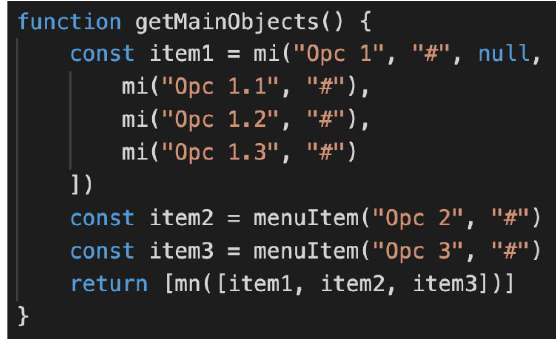
Figure 15. Implementation of the getMainObjects function to create a navigation menu